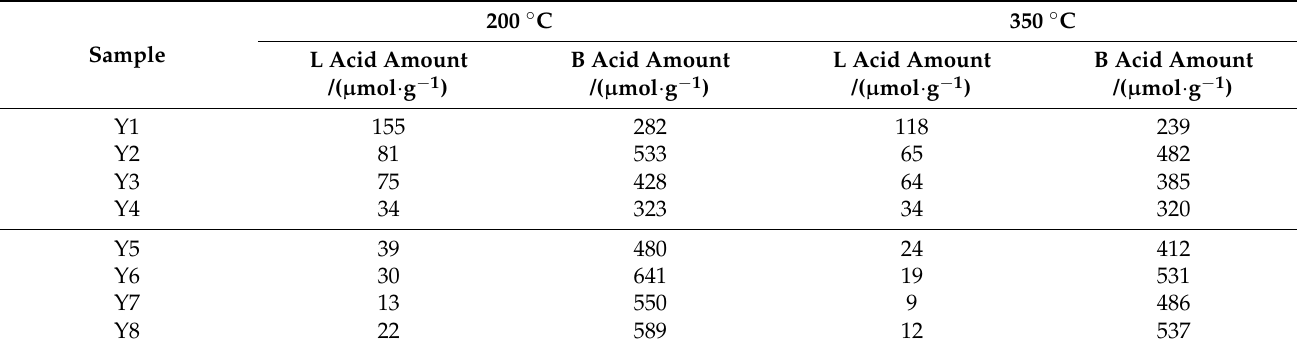
Table 3. Py-IR results of Y1–Y8.